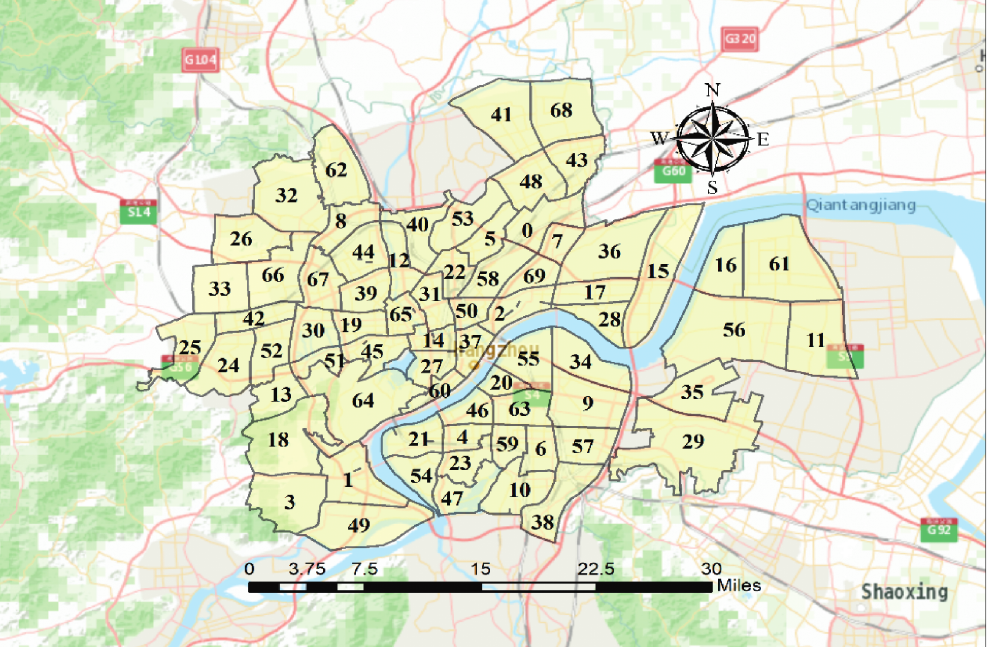
Figure 2: The layout of TAZs.